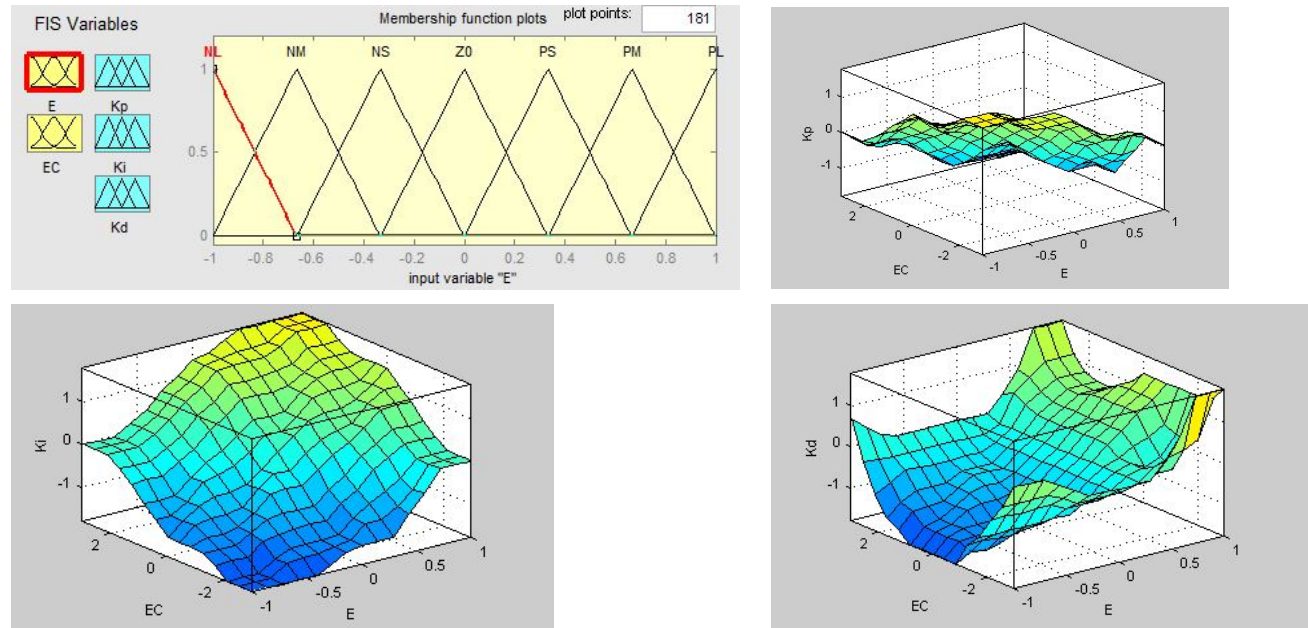
Figure 7. The membership function and surface viewer of the Fuzzy-PID controller.